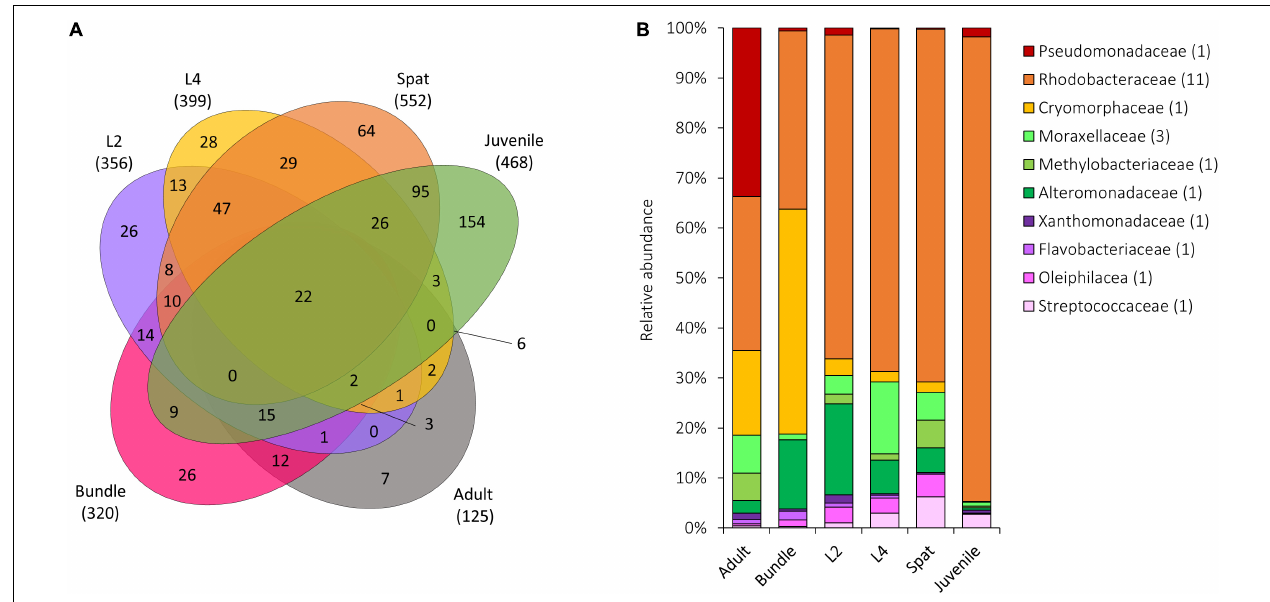
FIGURE 7 | Microbial communities shared across all life history stages of Acropora digitifera . (A) The number of OTUs unique to or shared between stages, with the total number of OTUs associated with each group represented in parentheses. (B) Relative abundance of the 28 bacterial OTUs shared among all generations. Sequences were classified at a family level where possible, with unclassified species indicated at higher taxonomic resolution. Numbers in parenthesis demark the number of different OTUs within the respective families. Adult, adult colonies; Bundle, egg-sperm bundles; L2, 2-day-old larvae; L4, 4-day-old larvae; Spat, newly settled spat; Juvenile, 6-month-old